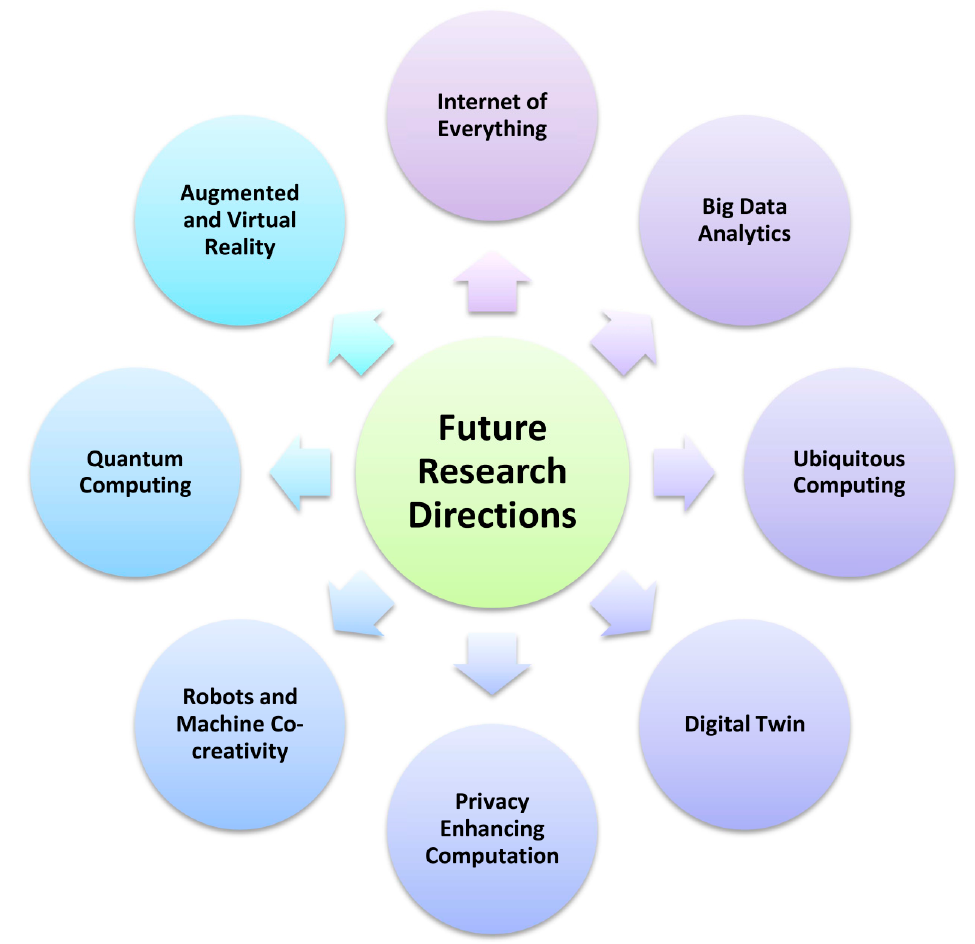
Figure 7. Future research directions in degenerative nerve disease diagnosis.